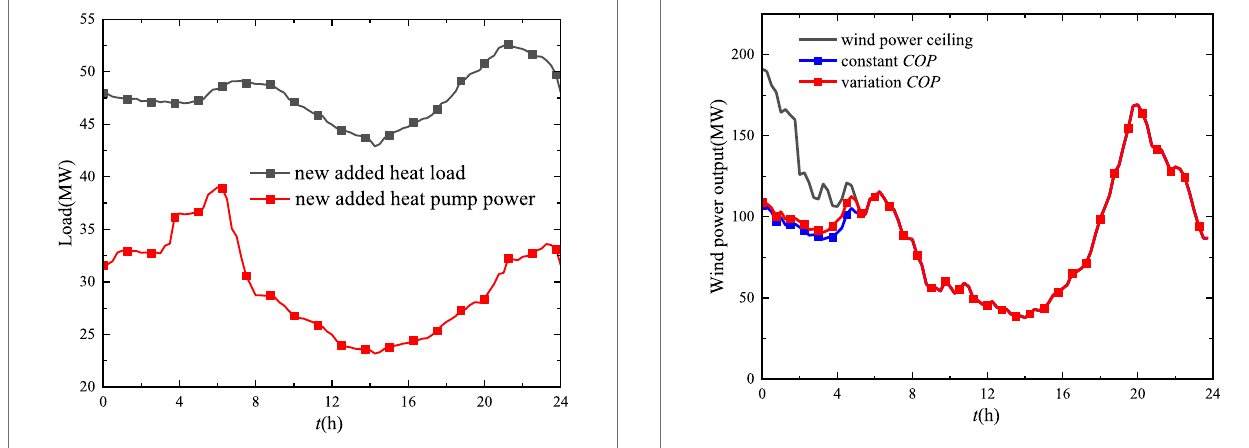
FIGURE 8 | In fl uences of the dynamic characteristics of the heat pump on wind power output.